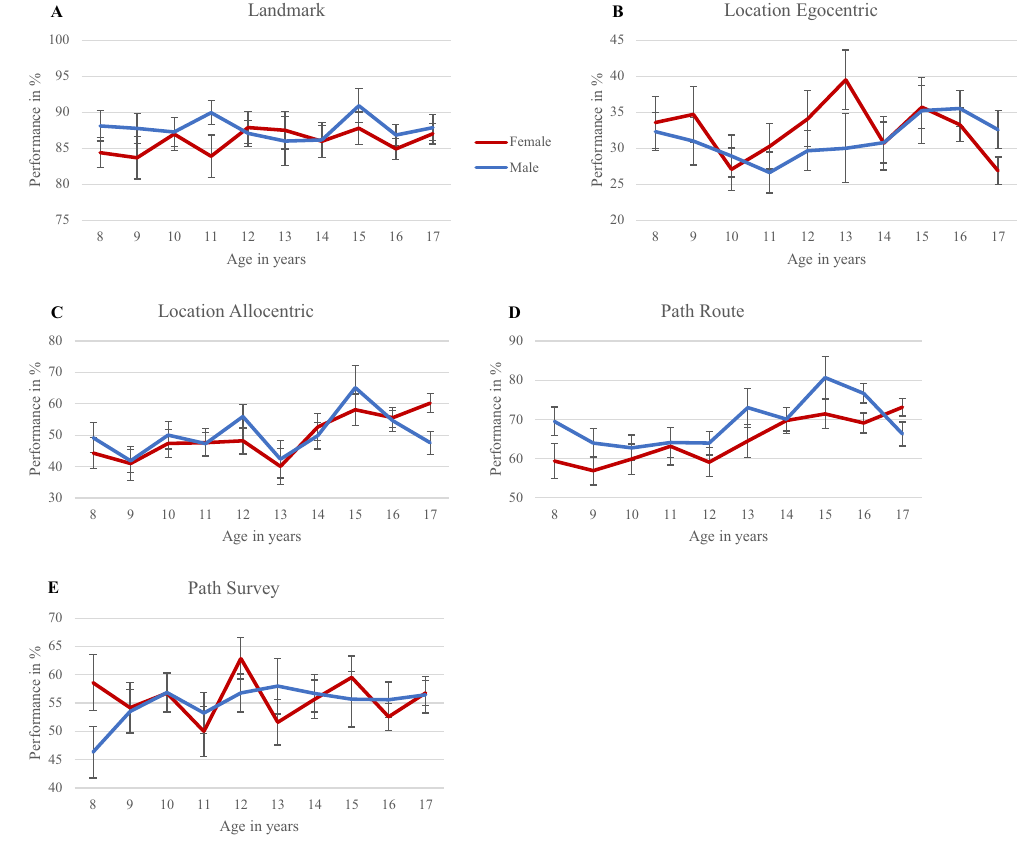
Figure 2. Mean performance of all children, for each age and gender on ( A ) Landmark task, ( B ) Location – Egocentric task, ( C ) Location – Allocentric task, ( D ) Path – Route task, ( E ) Path – Survey task. Error bars represent standard error of the